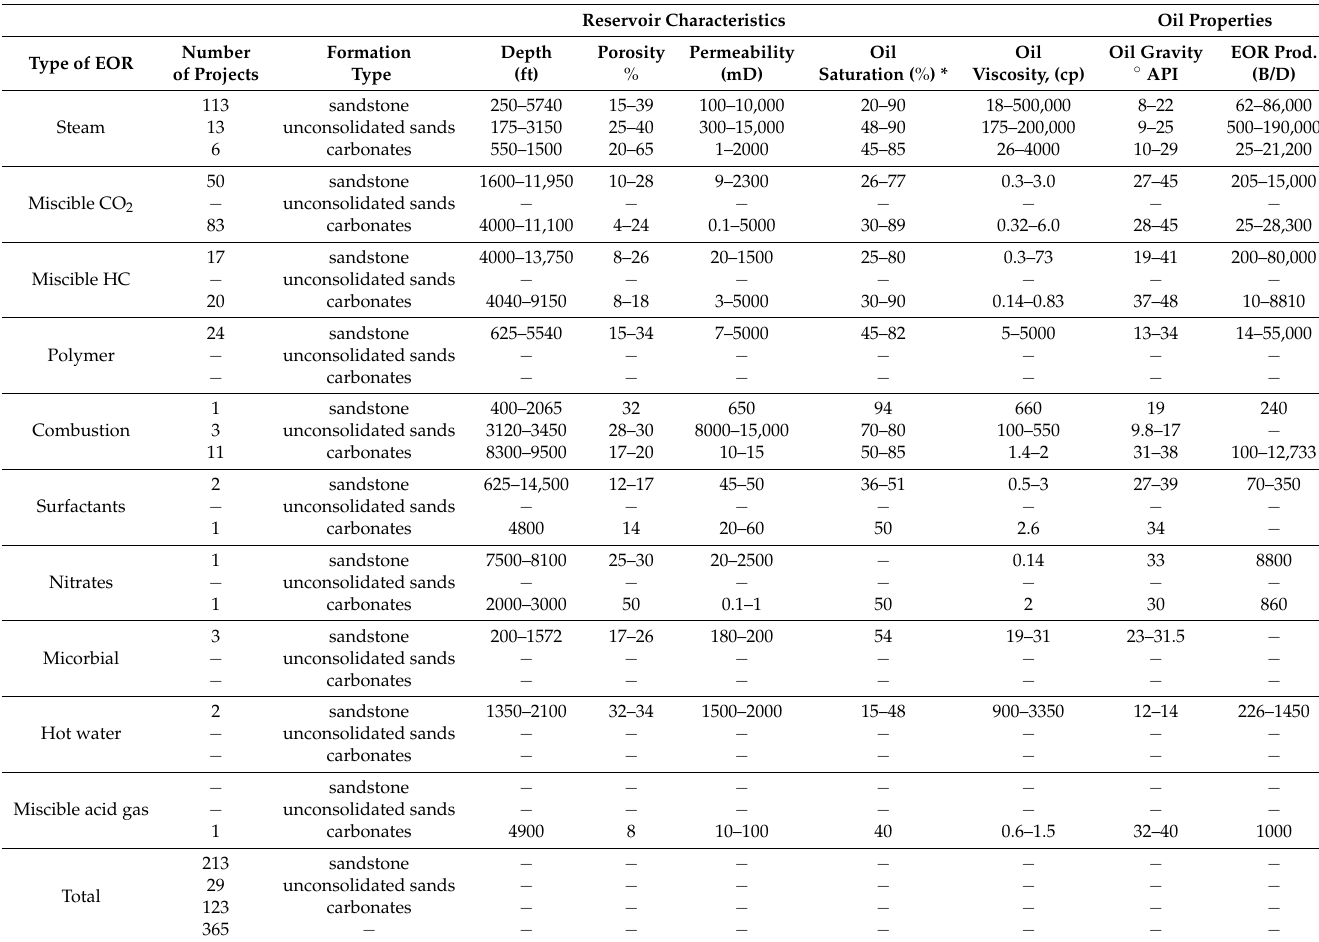
Table 2. Attributes of successful enhanced oil recovery (EOR) projects worldwide. Data source: